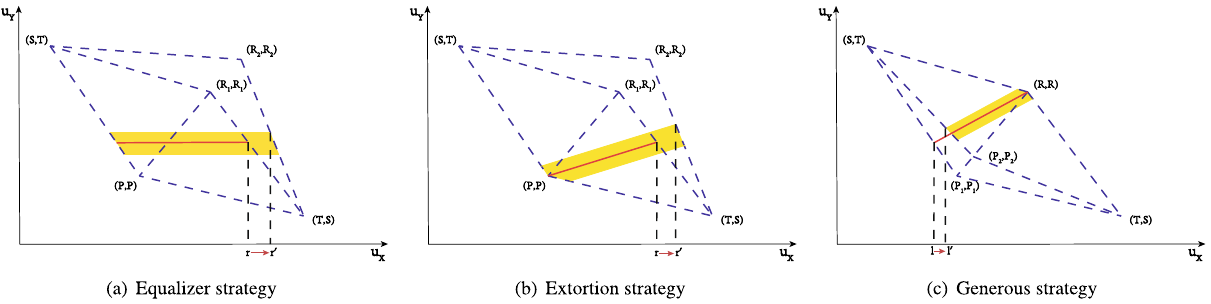
Figure 4. Player X can use either equalizer strategies and extortion strategies to raise the supremum of its expected utility or generous strategies to raise the infimum of its expected utility. ( a ) and ( b ) consider that ω 1 = [ T , R 1 , P , S ] and ω 2 = [ T , R 2 , P , S ] , where R 1 = R 2 ; ( c ) considers that ω 1 = [ T , R , P 1 , S ] and ω 2 = [ T , R , P 2 , S ] , where P 1 = P 2 . The red lines in ( a ), ( b ), and ( c ) describe utilities’ relationships when player X chooses an equalizer strategy, an extortion strategy, and a generous strategy in G 1 , respectively; The yellow area contains all possible relationships between players’ utilities in G 2 if player X does not change its strategy. In ( a ) and ( b ), r is the supremum of player X ’s utility in G 1 , and r ′ is lower than the supremum of player X ’s utility in G 2 ; In ( c ), l is the infimum of player X ’s utility in G 1 , and l ′ is lower than the infimum of player X ’s utility in G 2